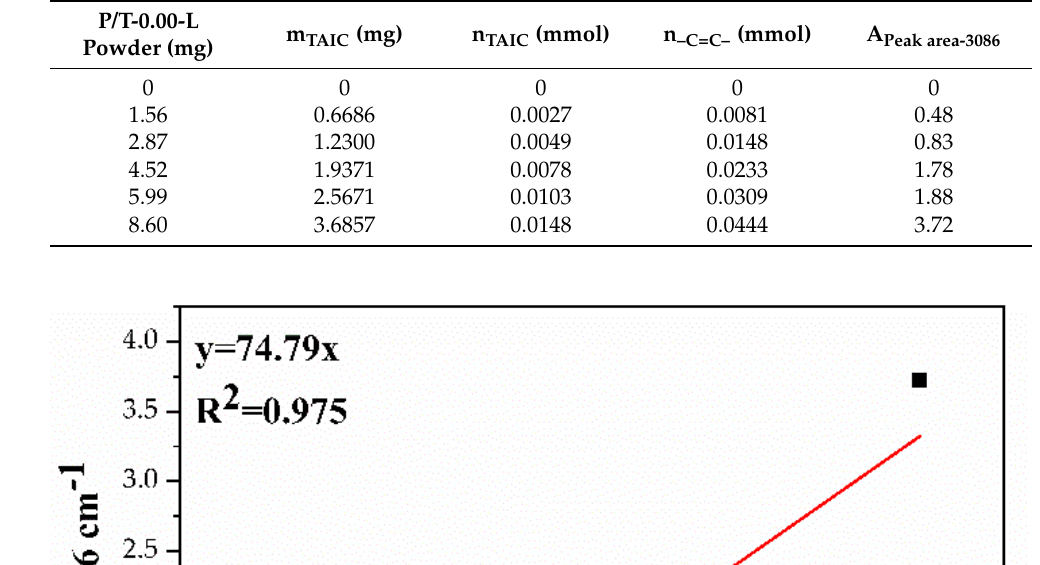
Table 3. Calculation of fitting data of different amounts of P/T-0.00-L sample powders.